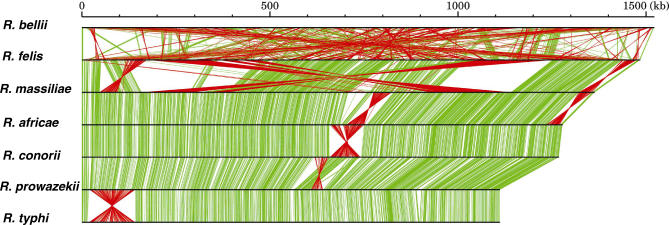
Linear Representation of Rickettsia GenomesThe size of horizontal bars corresponds to genome size. Orthologous relationships of the genes for two adjacently aligned genomes are indicated by green (if orthologs are encoded in the same direction) or red lines (if orthologs are encoded in different directions).